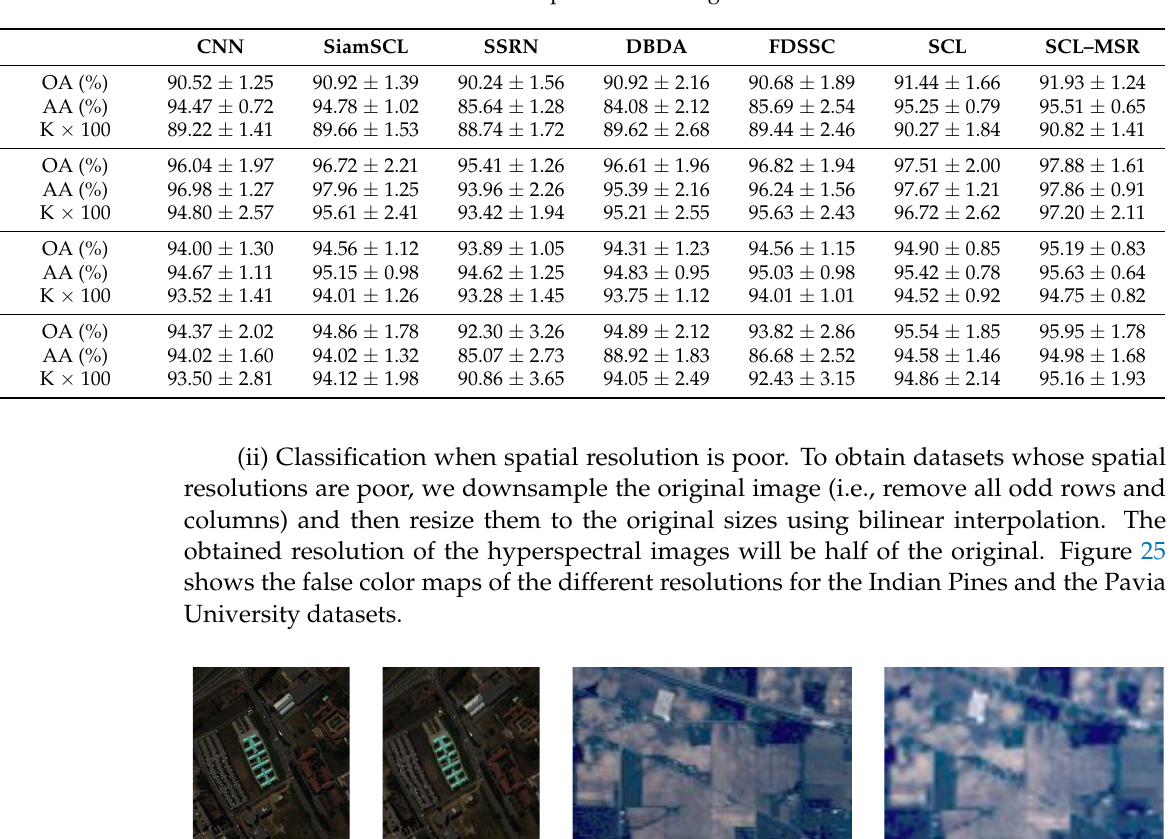
Table 10. Classification results after spectral unmixing.